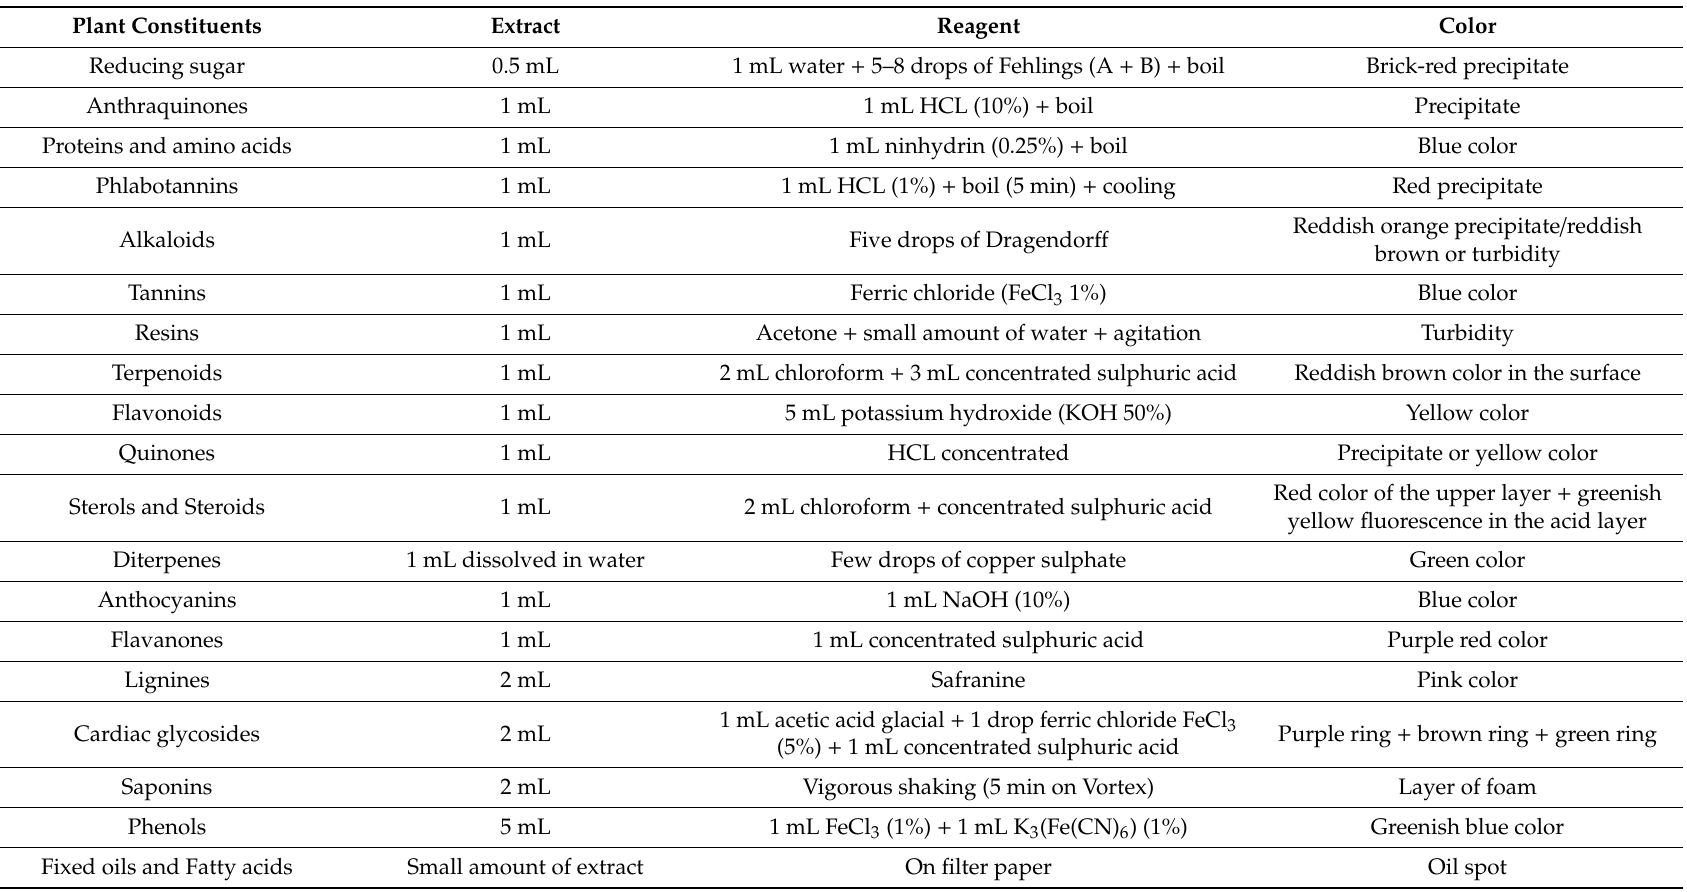
Table 1. Phytochemical used screening